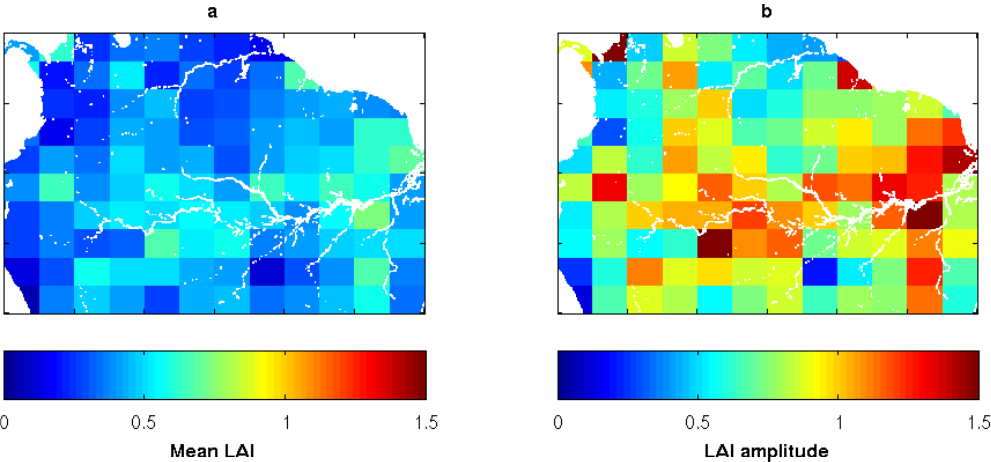
Fig. 5. Model uncertainty for mean LAI and annual amplitude (the difference between the maximum and minimum monthly LAI). We used samples drawn from the posterior distribution to calculate model LAI values and then obtain posterior means and confidence intervals. Here, the uncertainty is represented as the difference between the upper and lower bounds of the 95% conidence intervals using parameter posterior